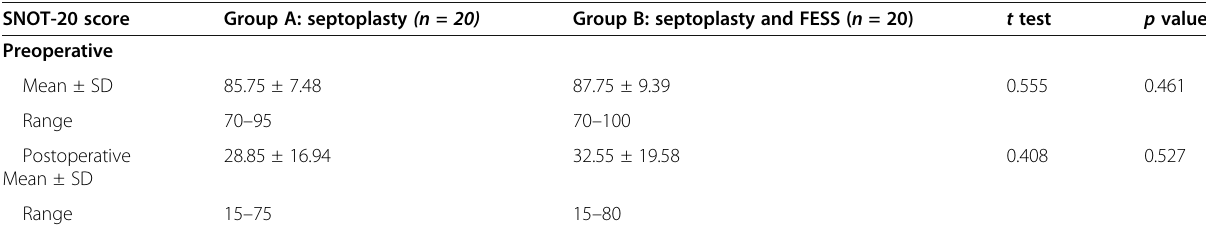
Table 2 Comparison between group A: septoplasty and group B: septoplasty and FESS as regards the pre- and post-operative SNOT-20